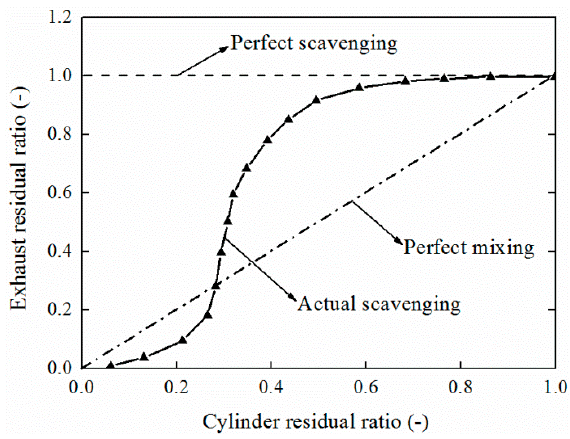
Figure 7. The uniflow scavenging profile.